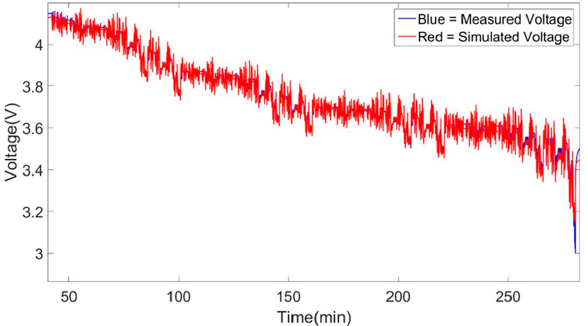
Figure 19. 2nd order Thévenin model measured and simulated worldwide harmonized light vehicle test procedure (WLTC) comparison at 25 °C with Coulomb counting and advanced characterization.